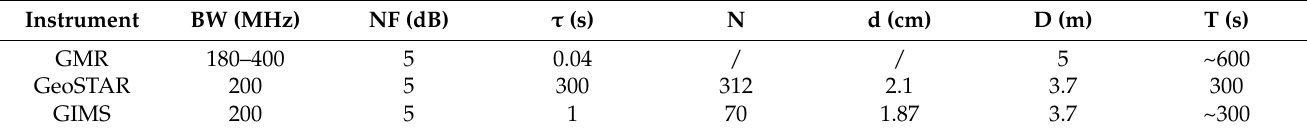
Figure 4. Simulated upwelling brightness temperature TB ( A – H ) and observation TA of GMR ( I – P ), GeoSTAR ( a – h ), and GIMS ( i – p ). ( A , I , a , i ) represents channel-1 50.3 GHz, ( B , J , b , j ) represents channel- 2 51.76 GHz, ( C , K , c , k ) represents channel-3 52.8 GHz, ( D , L , d , l )represents channel-4 53.596 GHz, ( E , M , e , m ) represents channel-5 54.4 GHz, ( F , N , f , n ) represents channel-6 54.94 GHz, ( G , O , g , o ) repre- sents channel-7 55.5 GHz, and ( H , P , h , p ) represents channel-8 57.29 GHz. Table 3. The simulation configurations of the three GEO-MW